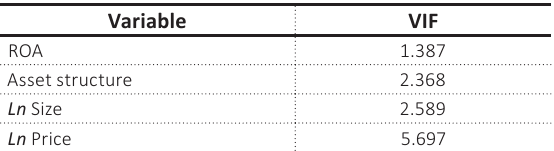
Table 4. Multicollinearity test results